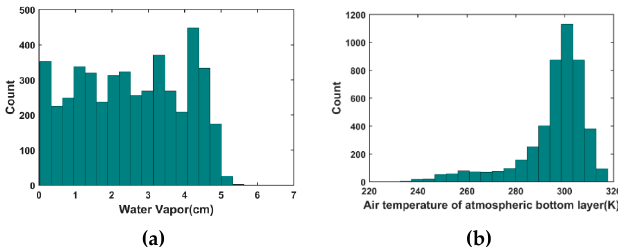
Figure 1. Histogram of water vapor ( a ) and air temperature of atmospheric bottom layer ( b ) of the selected Global Atmospheric Profiles from Reanalysis Information (GAPRI) atmospheric profiles.